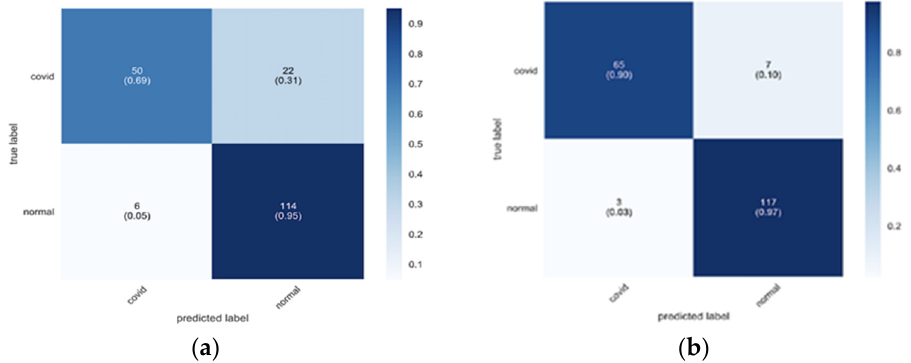
Figure 6. ( a ) With data augmentation; ( b ) without data augmentation